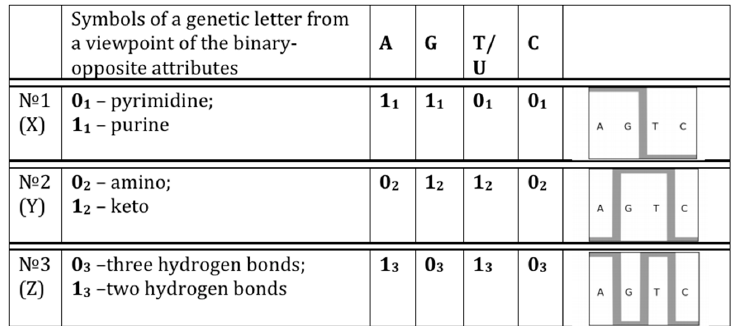
Figure 2. Three binary sub-alphabets according to three kinds of binary-opposite attributes in the set of nitrogenous bases C, A, G, T/U. Symbols X , Y , Z in the left column mean names of axes of Cartesian systems of coordinates. Schemes in the right column graphically symbolize each sub-alphabet, which is characterized by a set of numbers 0 and 1.